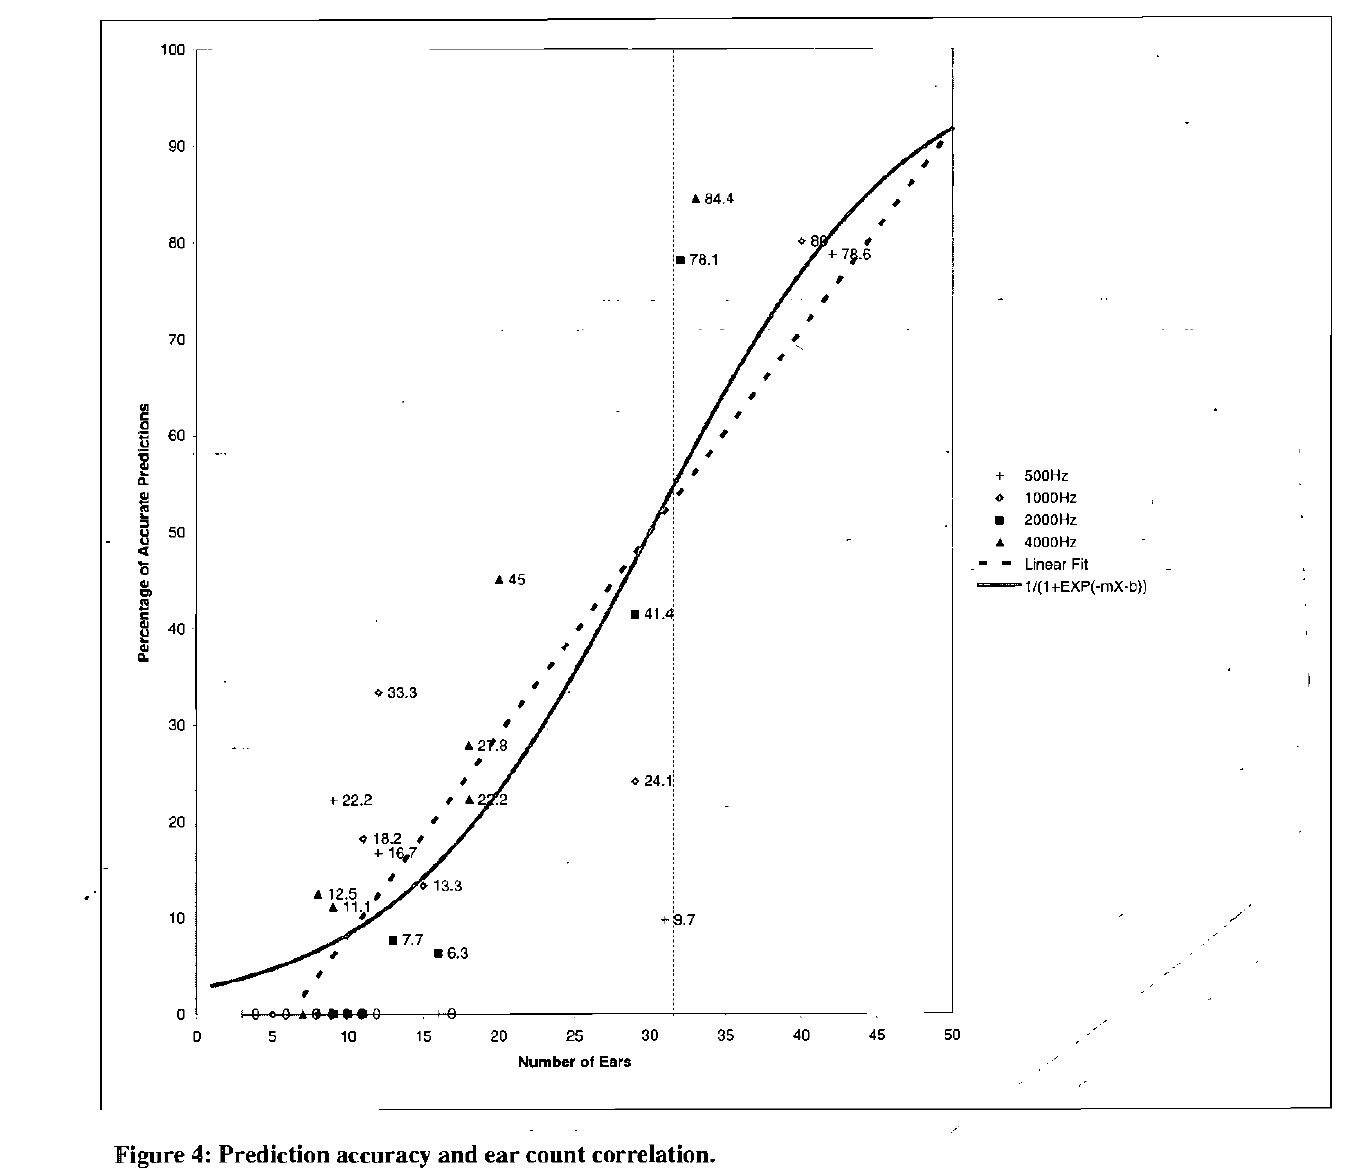
Figure 4: Prediction accuracy and ear count